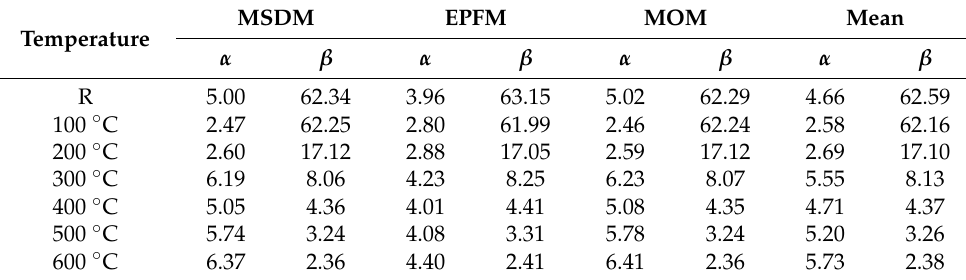
Table 3. Results of Weibull parameters (scale and shape parameters).